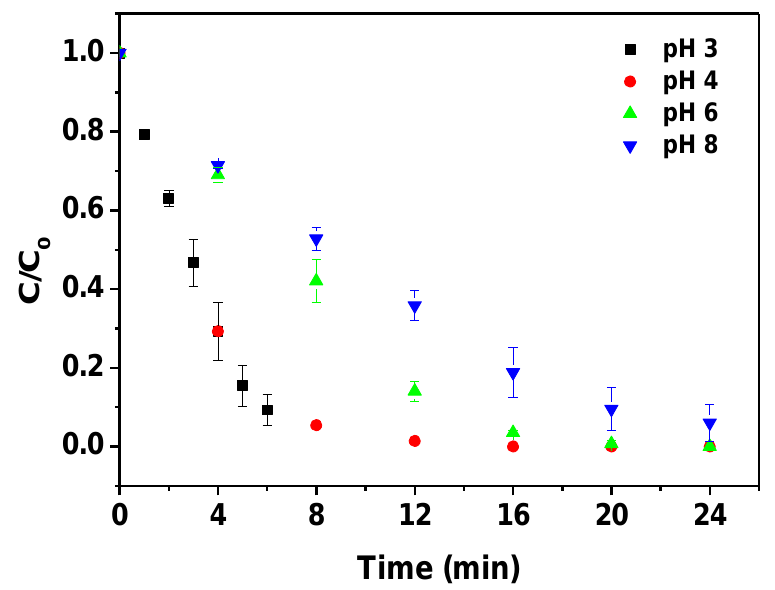
Figure 7. Oxytetracycline (OTC) degradation efficiency with different pH conditions ([PS] 0 = 1 mM, [OTC] 0 = 20 µ M, [HWWC] 0 = 0.2 g/L). PS: persulfate; HWWC: hand-warmer waste catalyst.